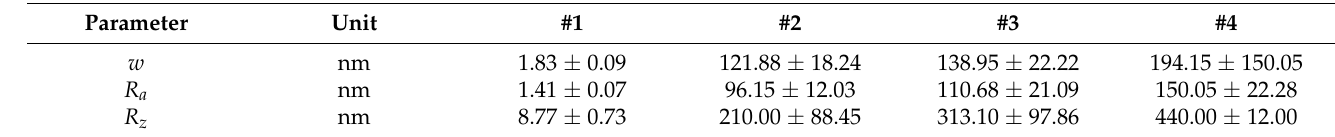
Figure 1. Relevant 2D and 3D AFM images: ( a ) ITO, ( b ) 5 cycles, ( c ) 15 cycles, and ( d ) 25 cycles. Table 1. Different surface roughness parameters of the